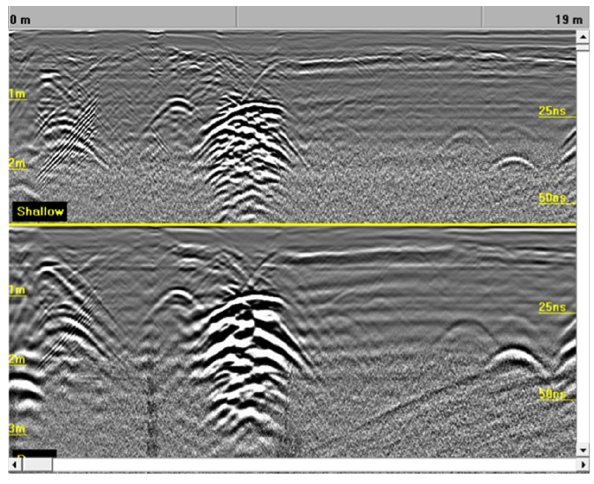
Figure 4. An example of GPR data.